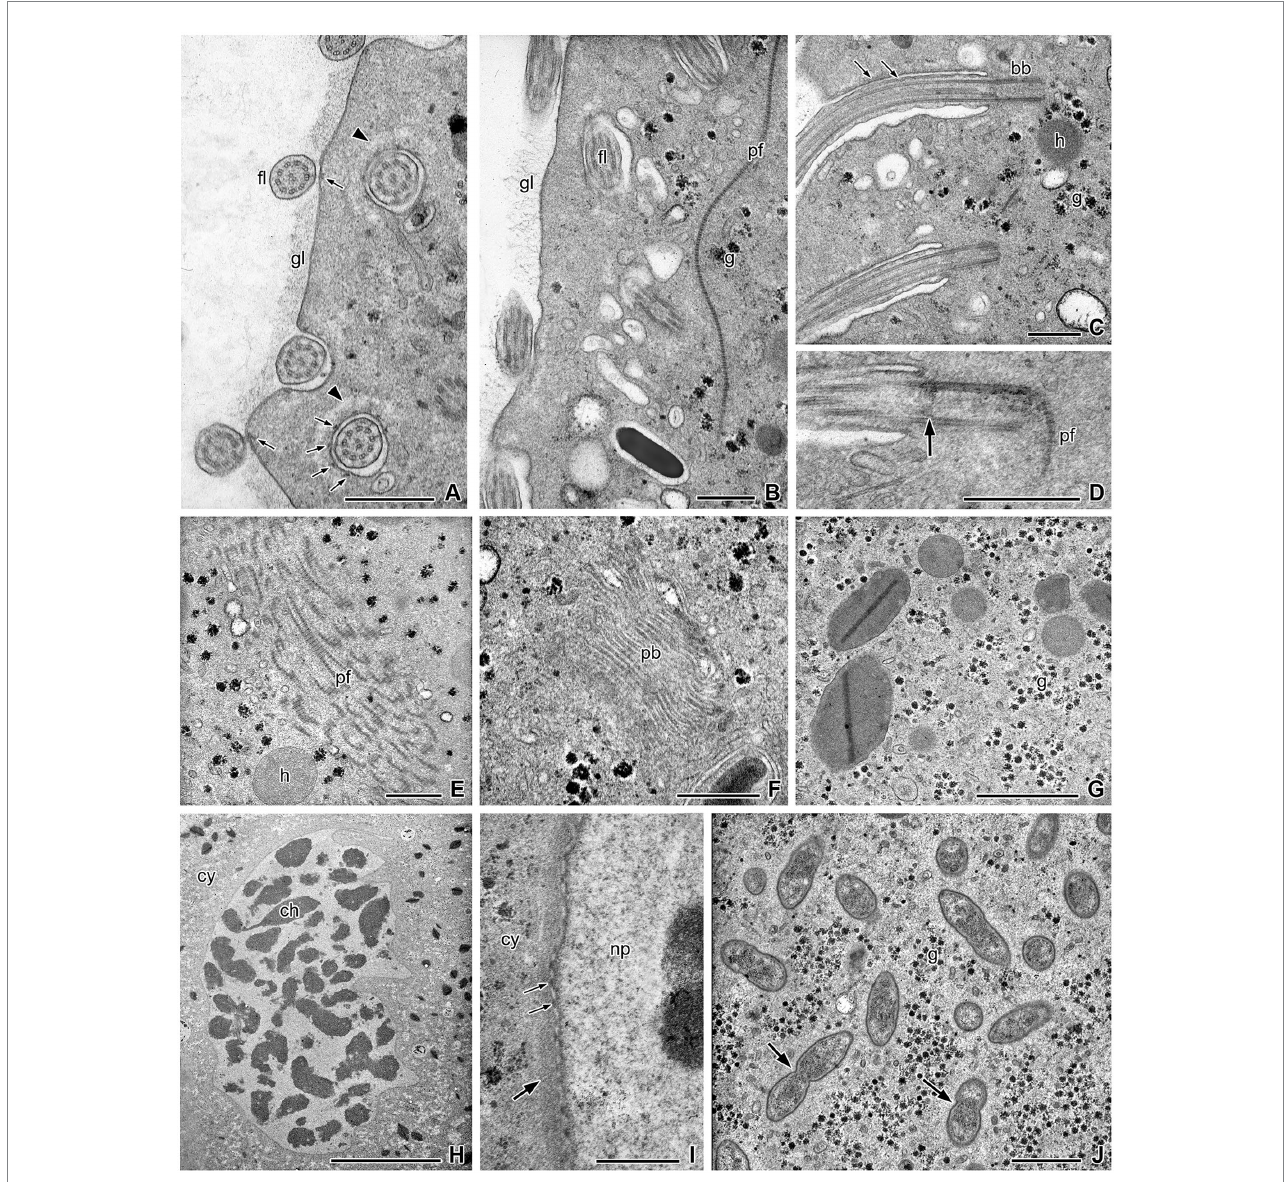
FIGURE 2 Ultrastructural details of the cell body of Retractinympha glossotermitis . (A) Body surface covered by thick layer of glycocalyx (gl); cross-sectioned flagella (fl) with contact sites to plasma membrane (thin arrows), and basal part of flagella in narrow depressions surrounded by bright zones of cytoplasm (arrowheads). (B) A cross-striated parabasal filament (pf) close to the flagellar region; glycogen (g). (C) Longitudinal sections of flagella and basal bodies (bb), arrows point to attachment sites; hydrogenosome (h). (D) Longitudinal section of basal body with transition plate to flagellum (arrow) and associated parabasal filament. (E) Strand of parabasal filaments. (F) Parabasal body (pb). (G) Small rounded hydrogenosomes and larger hydrogenosomes with interior stained plate. (H) Nucleus with condensed chromatin (ch); cytoplasm (cy). (I) Nuclear envelope with surrounding layer of dense cytoplasm (thick arrow) and nuclear pores (thin arrows); nucleoplasm (np). (J) Endobiotic bacteria (arrows) in direct contact to the cytoplasm. Transmission electron microscopy. Scale bars (A–G,I) 0.5 μ m, (H) 10 μ m, (J) 1 μ